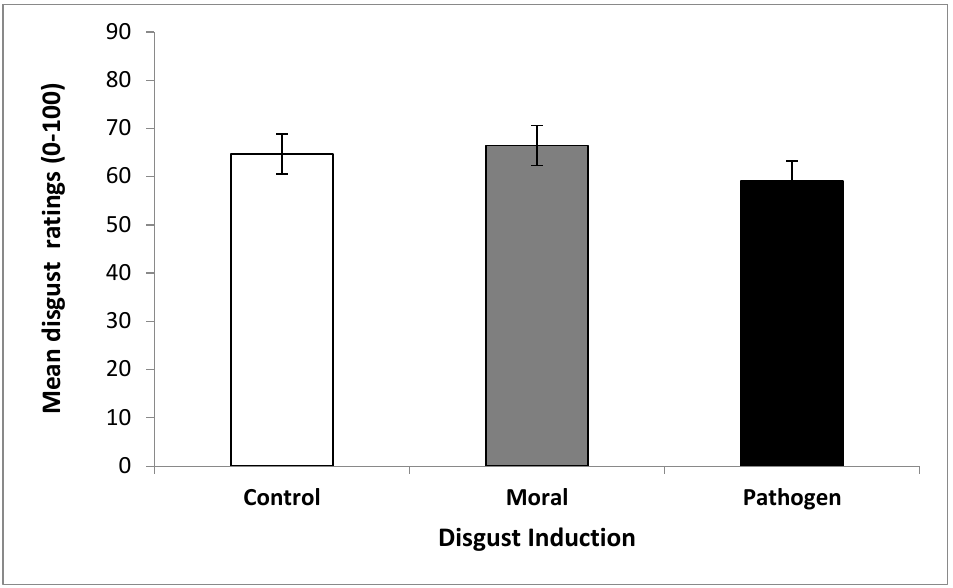
Figure 1. Mean (±SE) disgust ratings for disgust odor, dependent on disgust induction (Experiment 1).